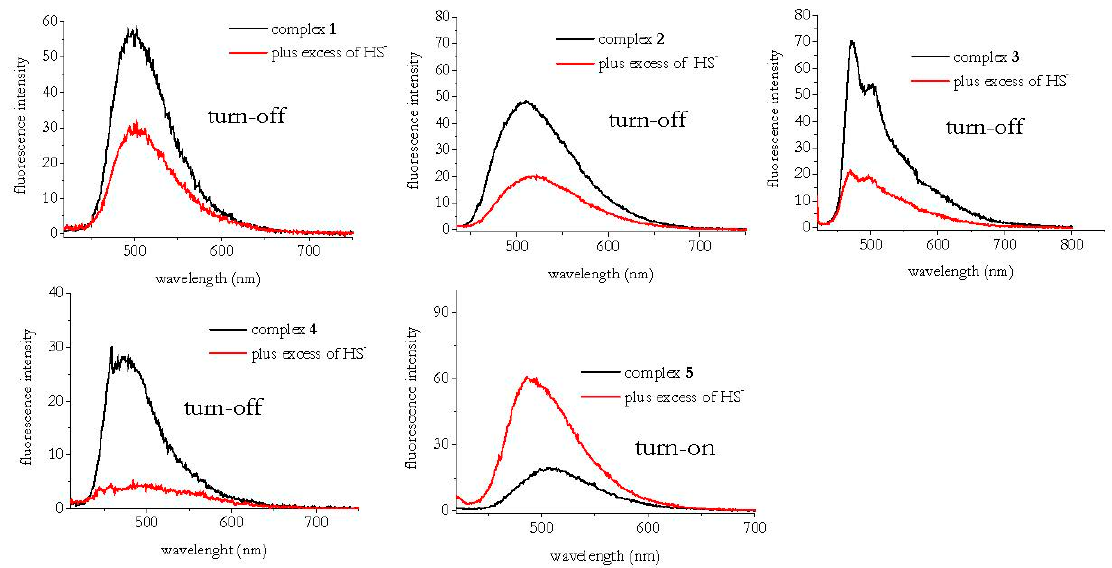
Figure 2. Emission spectra of complexes 1 − 5 before and after the addition of 5 equiv of NaSH. [Complexes 1 – 5 ] = 1 × 10 − 5 M; [NaSH] = 5 × 10 − 5 M. All spectra were measured in DMSO with λ exc = 402 nm for complex 1 ; λ exc = 424 nm for complex 2 ; λ exc = 413 nm for complex 3 ; λ exc = 391 nm for complex 4 ; and λ exc = 410 nm for complex 5